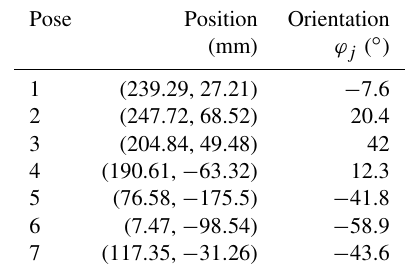
Table 3. Seven precision